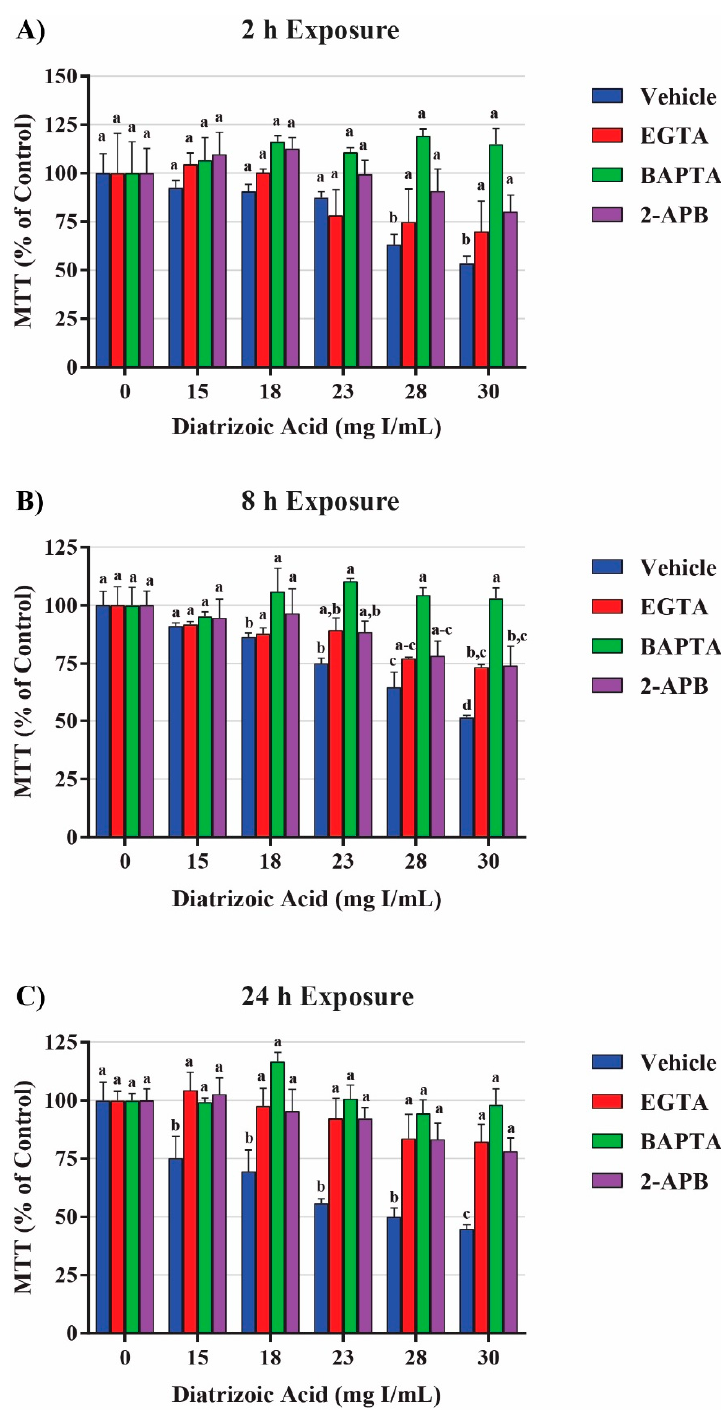
Figure 18. Effects of EGTA (extracellular calcium chelator), BAPTA-AM (intracellular calcium chelator), or 2-APB (inositol triphosphate receptor antagonist) pretreatment on mitochondrial viability in HK-2 cells. DA induced cytotoxicity was attenuated in response to calcium concentration modulators. BAPTA-AM offered protection from DA-induced cytotoxicity within 2 h ( A ), 8 h ( B ), and 24 h ( C ). EGTA and 2-APB provided partial protection from DA-induced cytotoxicity within 8 h ( B ) and 24 h ( C ). Different superscripts (a–d) indicate a statistical difference ( p < 0.05) between groups. Values represent mean ± SEM for three independent experiments.